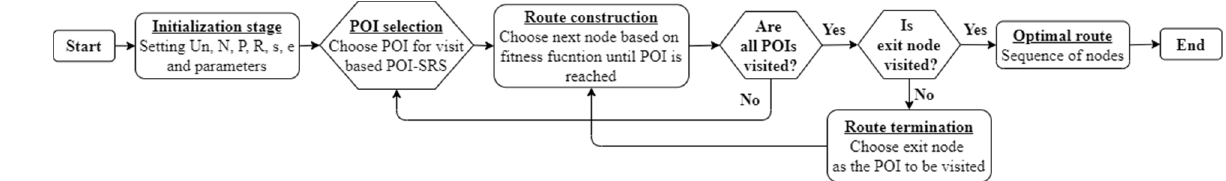
Figure 1. Flowchart of the greedy graph-based pathfinding algorithm (GPA) [11].